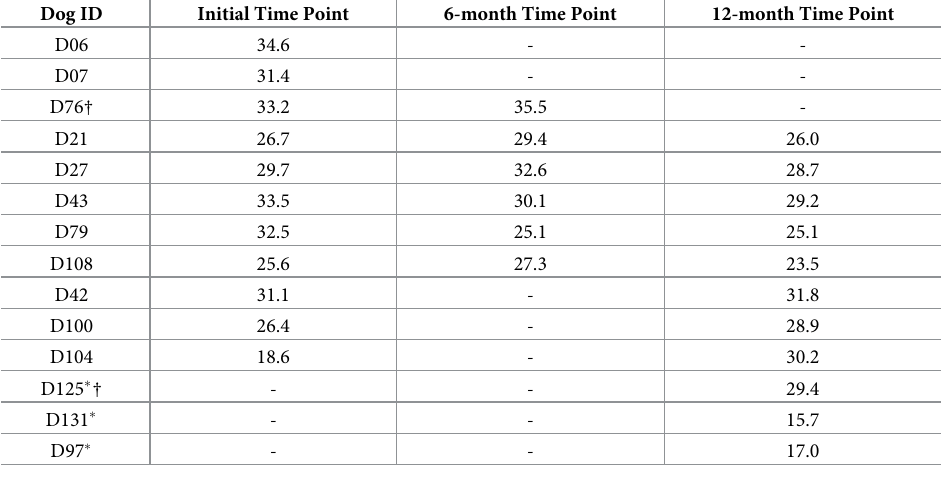
Table 3. PCR results (Ct values) for dogs with a Ct value indicating a T . cruzi- positive sample. No Ct value or a Ct value of 36 or higher during qPCR is considered a negative PCR result and is noted as “-” in this